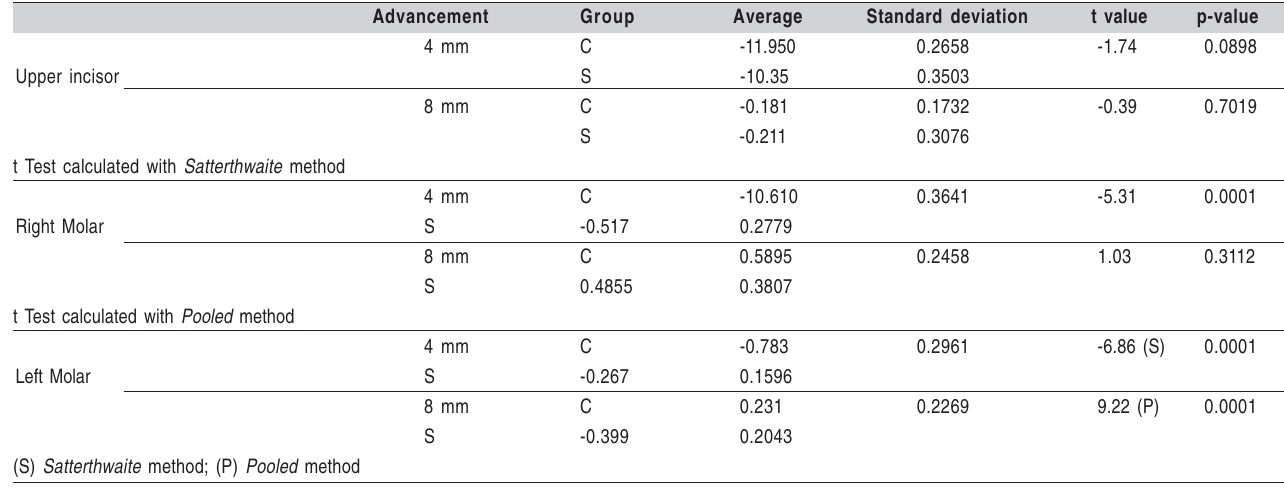
Table 1. Average, standard deviation, and student t test for comparison of vertical variable from analyzed groups in advancement of 4 and 8 millimeters